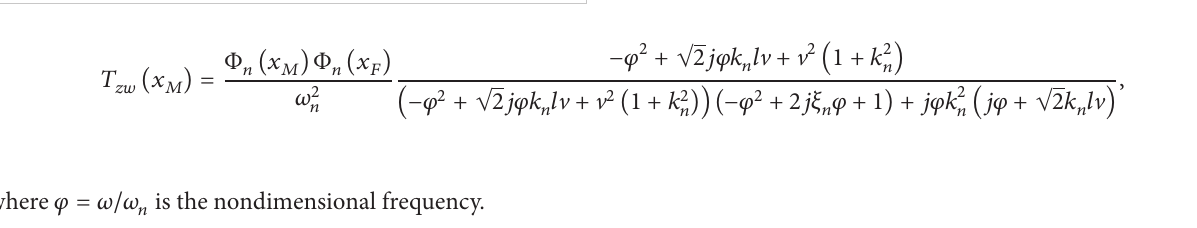
It should be noted that the use of (13) and (15) (which are yielded considering 𝜉 𝑛 = 0 ) in the case of damped systems introduces certain approximations. Nevertheless, these approximations can be assumed as negligible. In fact, according to [19], the maximum difference between the atten- uation provided by (13) and (15) and the actual attenuation is less than 0.5 dB for most practical